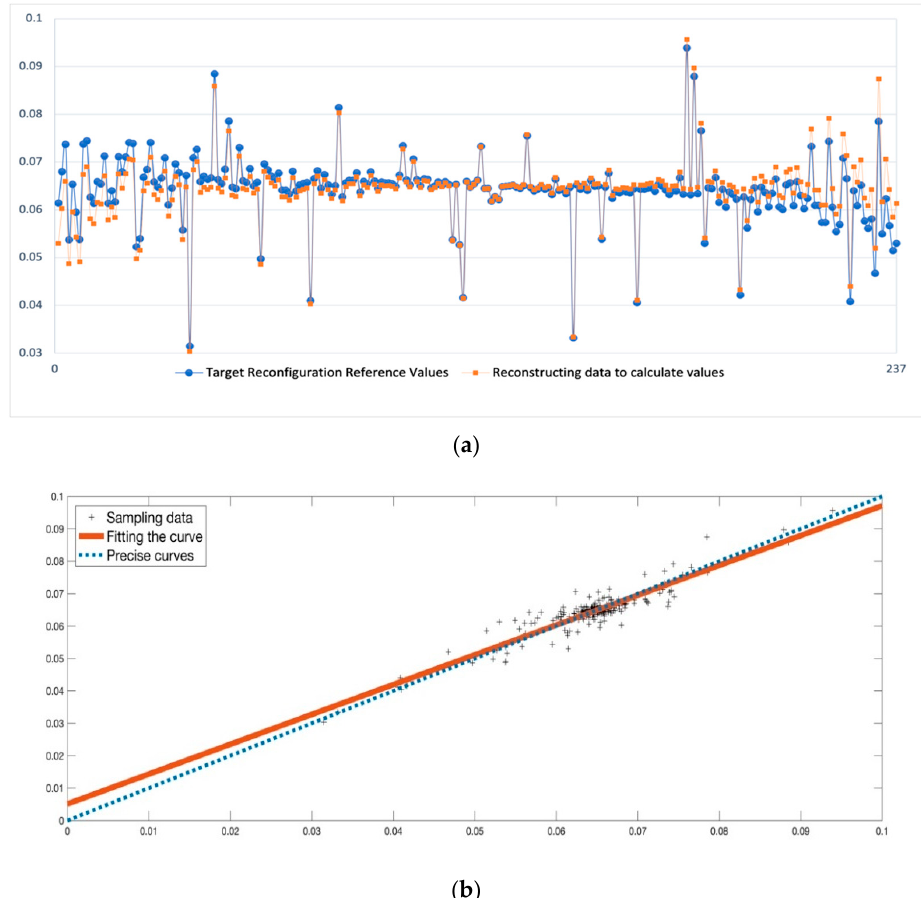
Figure 3. Global container shipping network reconfiguration results comparison (237 ports): ( a ) di ‐ rect comparison; ( b ) fitted comparison.